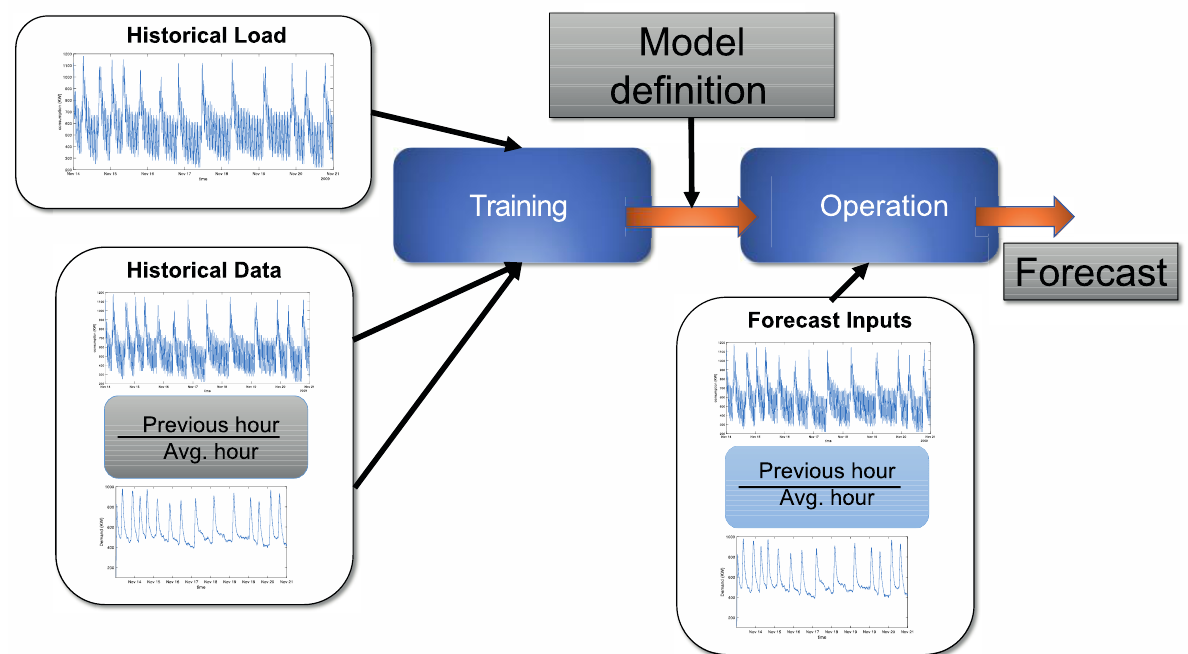
Figure 11. Working scheme with neural networks using the Deep learning machine tool from MATLAB. To address the observed seasonality, the series is additionally given a delay, according to the seasonality. In this case, the seasonality of one hour corresponds to ten units of time of six minutes, so a delay of ten units is introduced to the